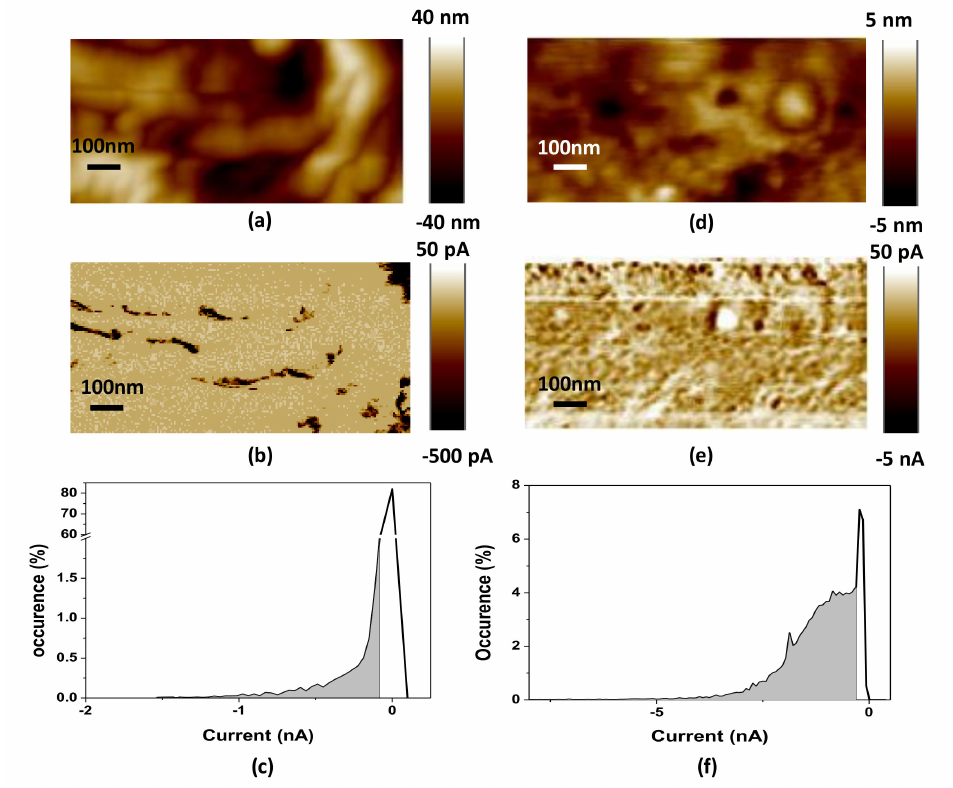
Figure 10. C-AFM results over 1 µ m × 0.5 µ m surface. ( a ) Topography, ( b ) current map, and ( c ) corresponding occurrence diagrams for TiO 2 -GC with an applied voltage of − 8 V; ( d ) Topogra- phy, ( e ) current map, and ( f ) corresponding occurrence diagrams for TiO 2 -BIO with an applied voltage of − 10